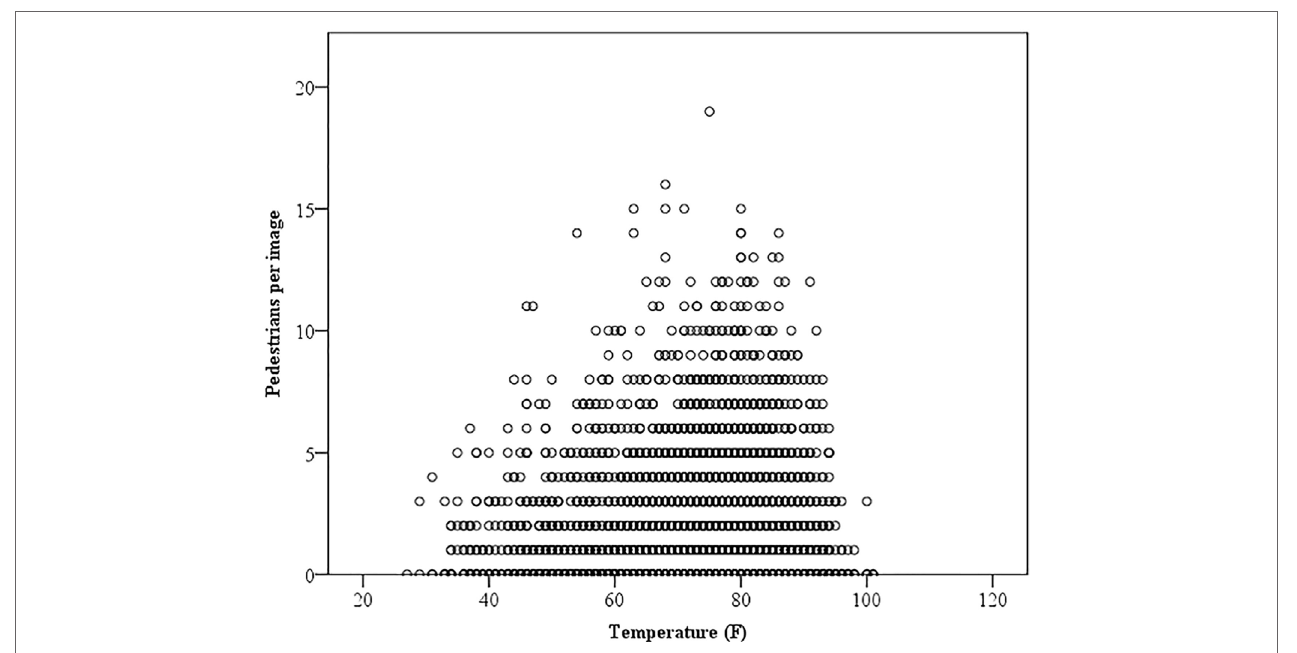
FigUre 3 | number of pedestrians per image across temperature .